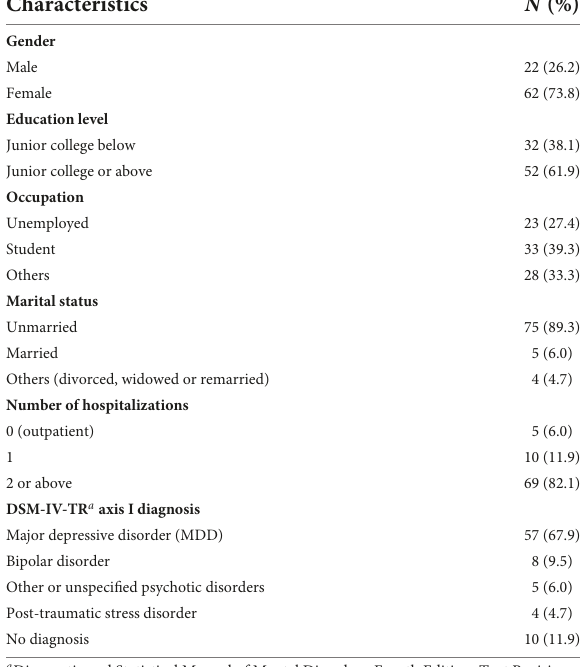
TABLE 1 Characteristics of Chinese borderline personality disorder (BPD) patients ( N = 84).